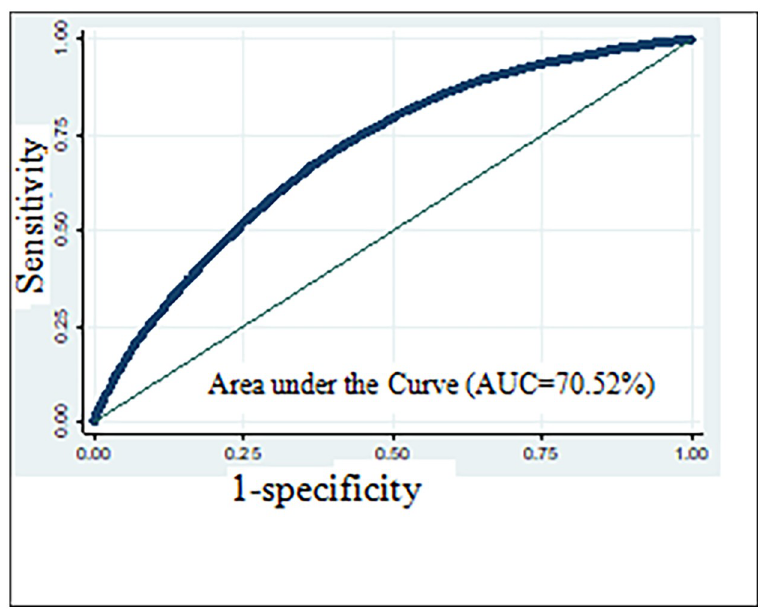
Fig 5. Area under the receiver operating characteristic (AUC) curve for CIAF